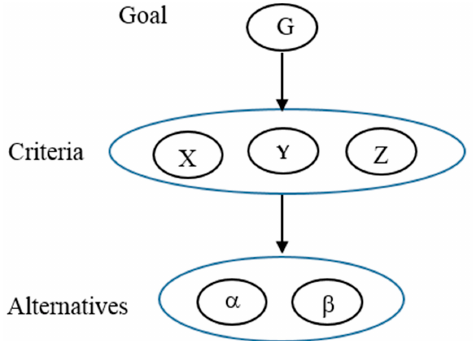
Figure 7. ANP network structure for a standard 3-level AHP model.